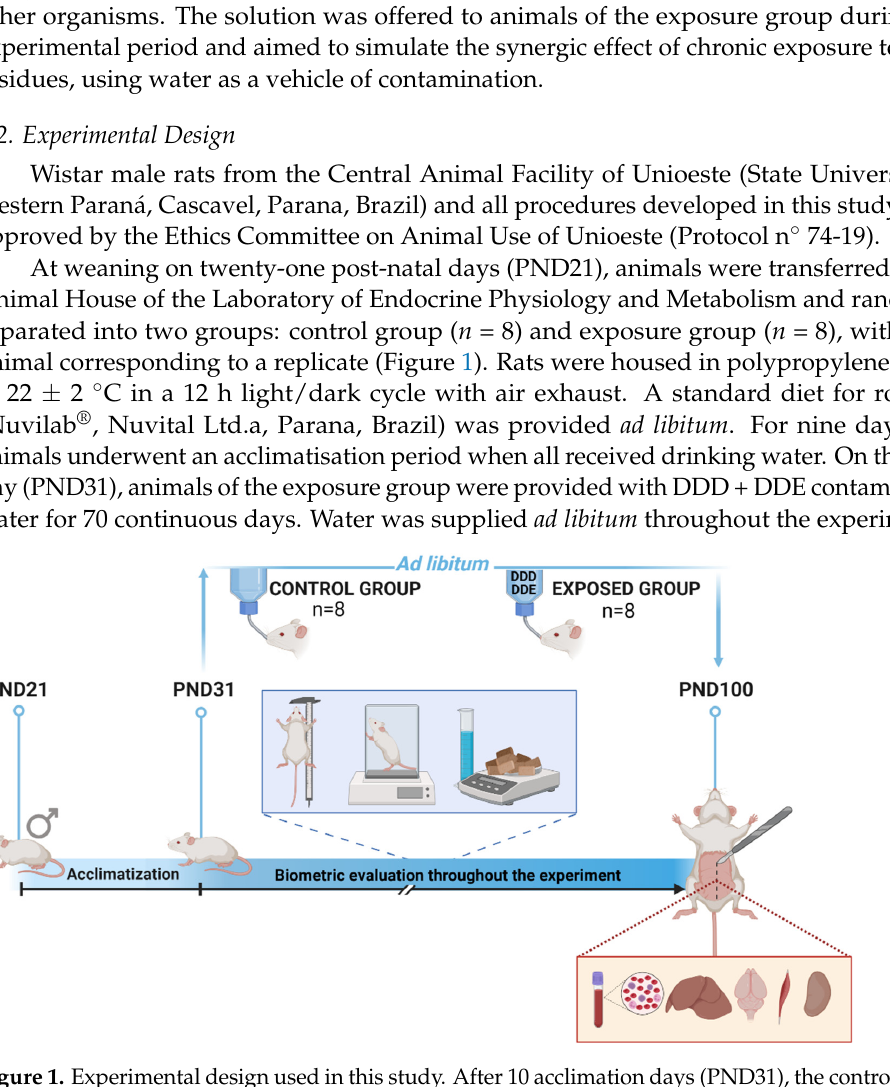
Figure 1. Experimental design used in this study. After 10 acclimation days (PND31), the control group received uncontaminated water until the end of the experiment (PND100) and the exposure group received water contaminated with DDD (0.002 mg.L − 1 ) + DDE (0.005 mg.L − 1 ) for 70 continuous days. Biometrics were evaluated for both groups between PND31 and PND100. Daily water consumption and weekly consumption of the standard diet were determined. Body weight and naso-anal length were measured weekly. (Figure created using